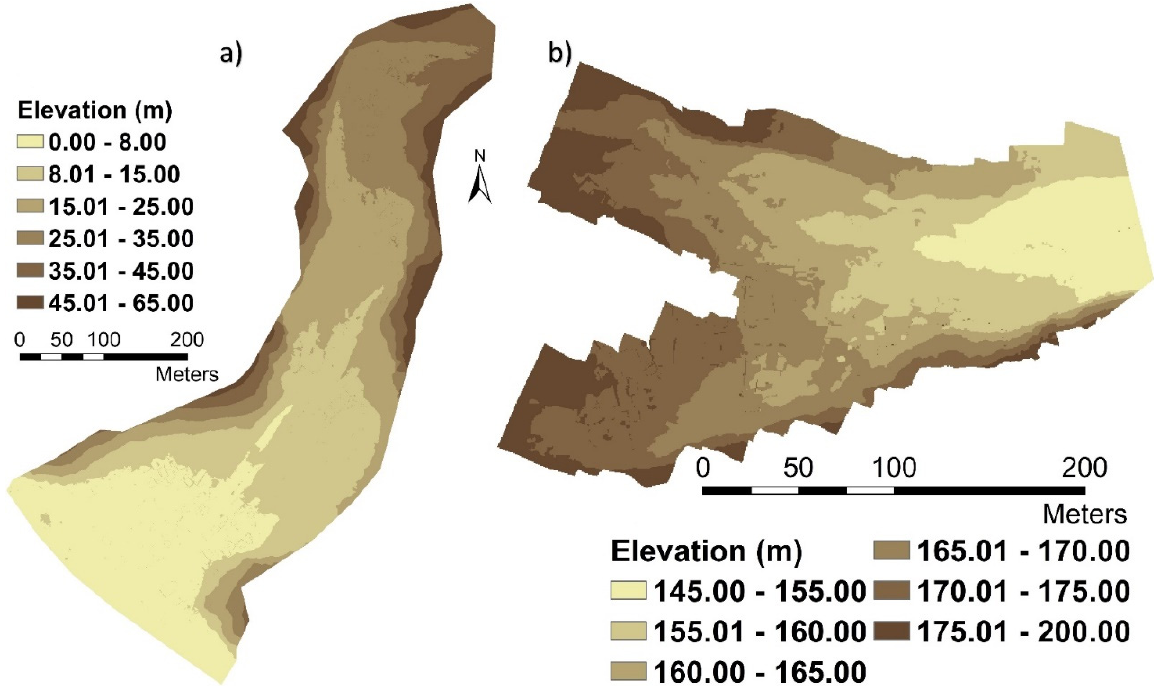
Figure 10. ( a ) The generated pre-event DTM for Coulibistrie (filled with LiDAR DTM). ( b ) The generated pre-event DTM for Pichelin (filled with LiDAR DTM).